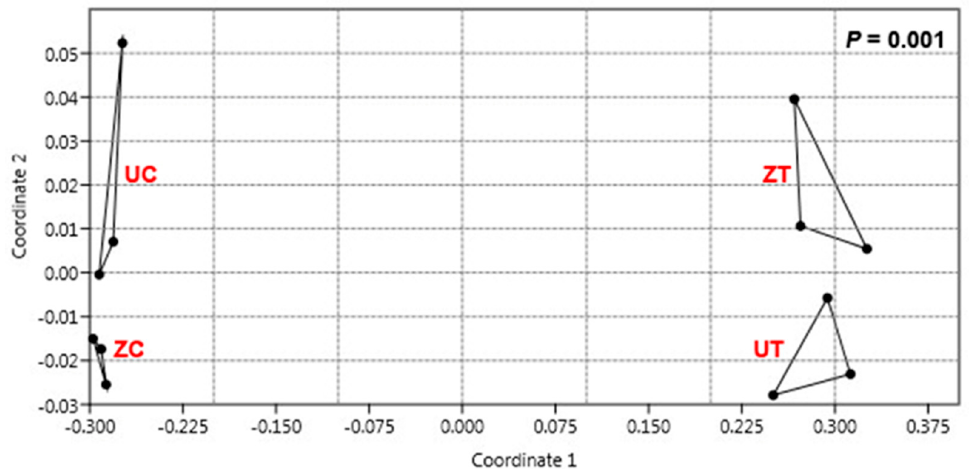
Figure 4. The non-metric dimensional scaling (N-MDS) analysis demonstrates distances between 771 OTUs identified from the rhizospheric bacterial communities of cultivars “Umsila” (UC) and “Zabad” (ZC) when grown under control conditions and “Umsila” (UT) and “Zabad” (ZT) cultivars when grown under salinity. The pairwise comparison using PERMANOVA showed a significant difference ( p = 0.001) between the control and saline community groups.